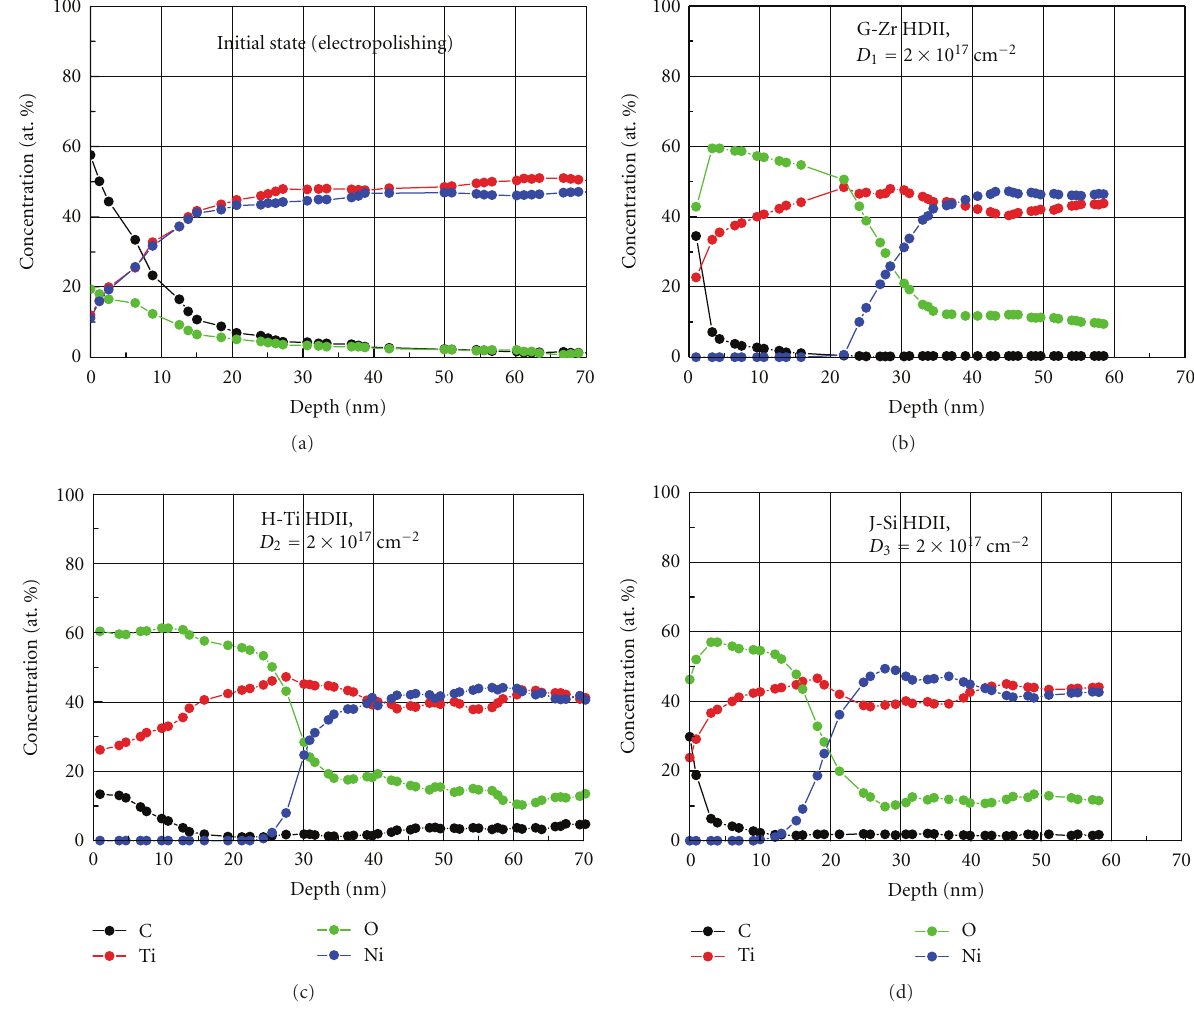
Figure 2: Chemical (elemental) composition of the NiTi specimen surfaces before (a) and after modification with Zr (b), Ti (c), and Si (d) ion beams. Auger electron